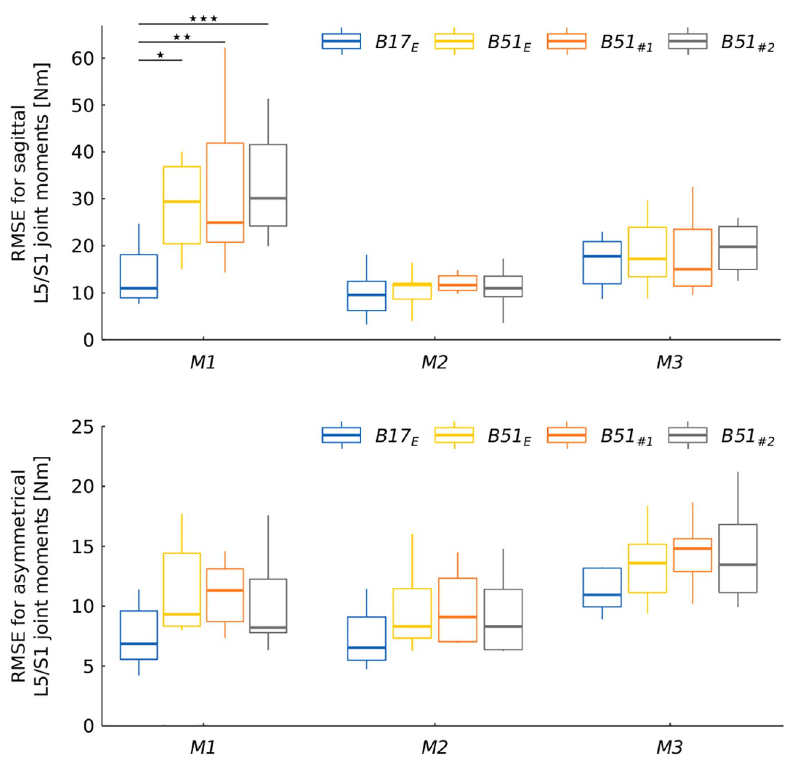
Fig 6. RMSE for sagittal and asymmetrical L5/S1 joint moments according to prediction method and box configuration. � significance level � 0.05; �� significance level � 0.01; ��� significance level � 0.001.